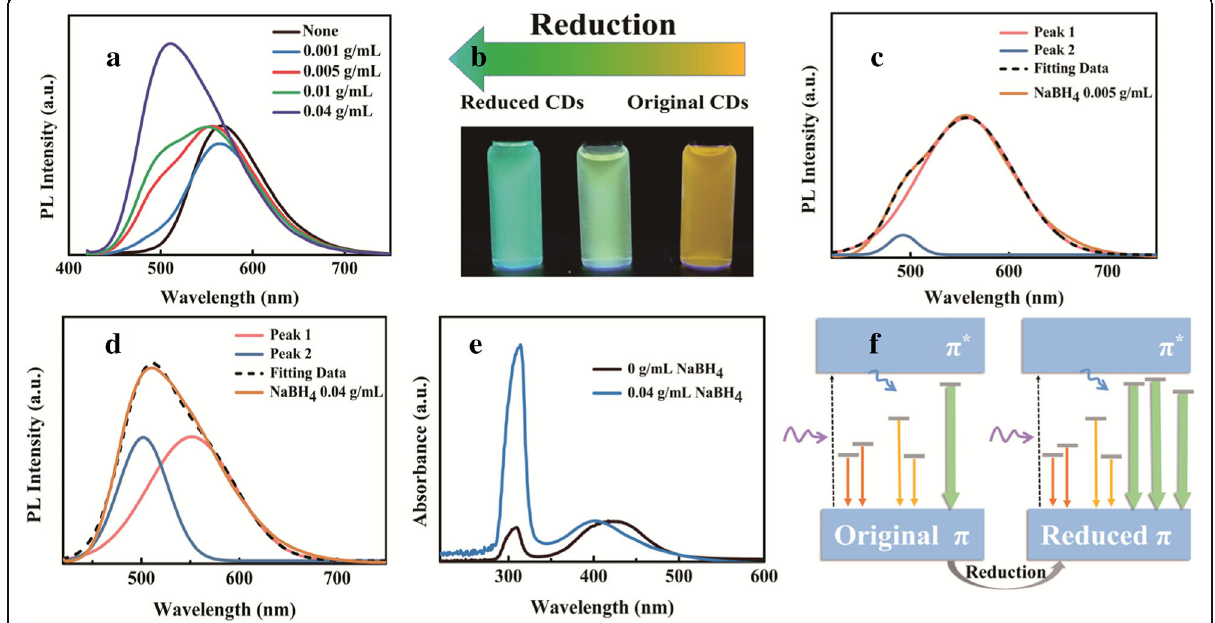
Fig. 3 a PL spectra of NCDs treated with different concentration of NaBH 4 ranging from 0 to 0.04 g/mL, λ ex = 400 nm. b Digital photographs of NCDs treated with 0, 0.01, and 0.04 g/mL NaBH 4 under an UV lamp. Deconvoluted PL spectra of NCDs treated with c 0.005 and d 0.04 g/mL NaBH 4 separately with two emission bands of peak 1 and peak 2. e UV-vis absorption spectra of NCDs treated with 0 and 0.04 g/mL NaBH 4 . f The schematic illustration of the proposed emission process in the original and reduced